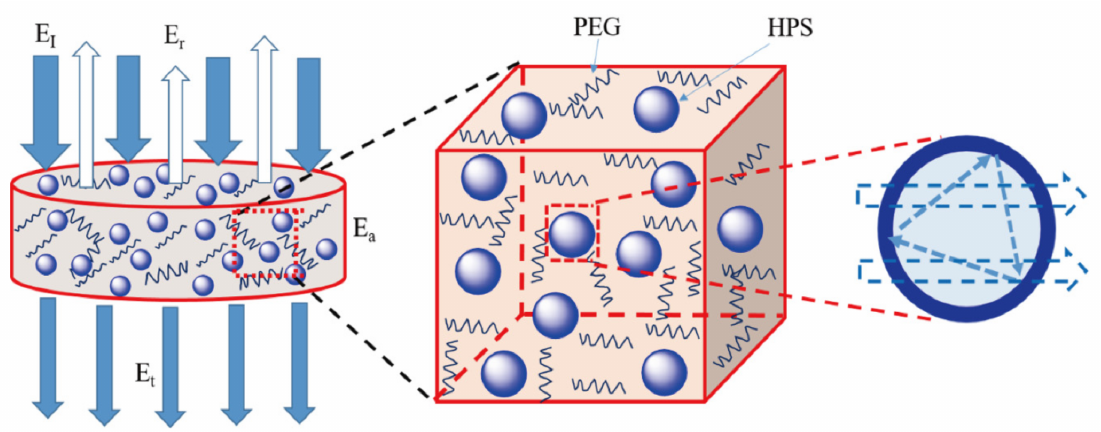
Figure 7. Scheme of the soundwave dispersion into the HPS/PEG/EP